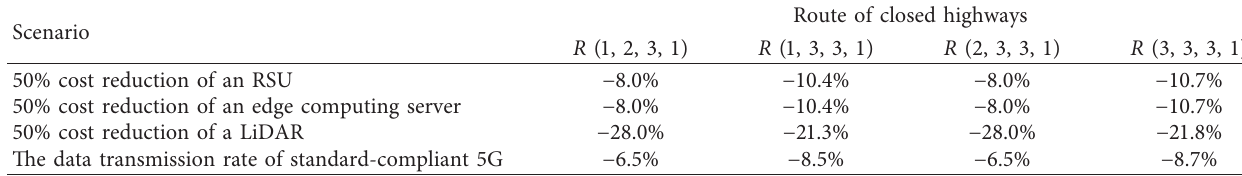
Table 5: Scenario analysis: impact of key elements on the total upgrade cost per kilometer on closed highways. Scenario